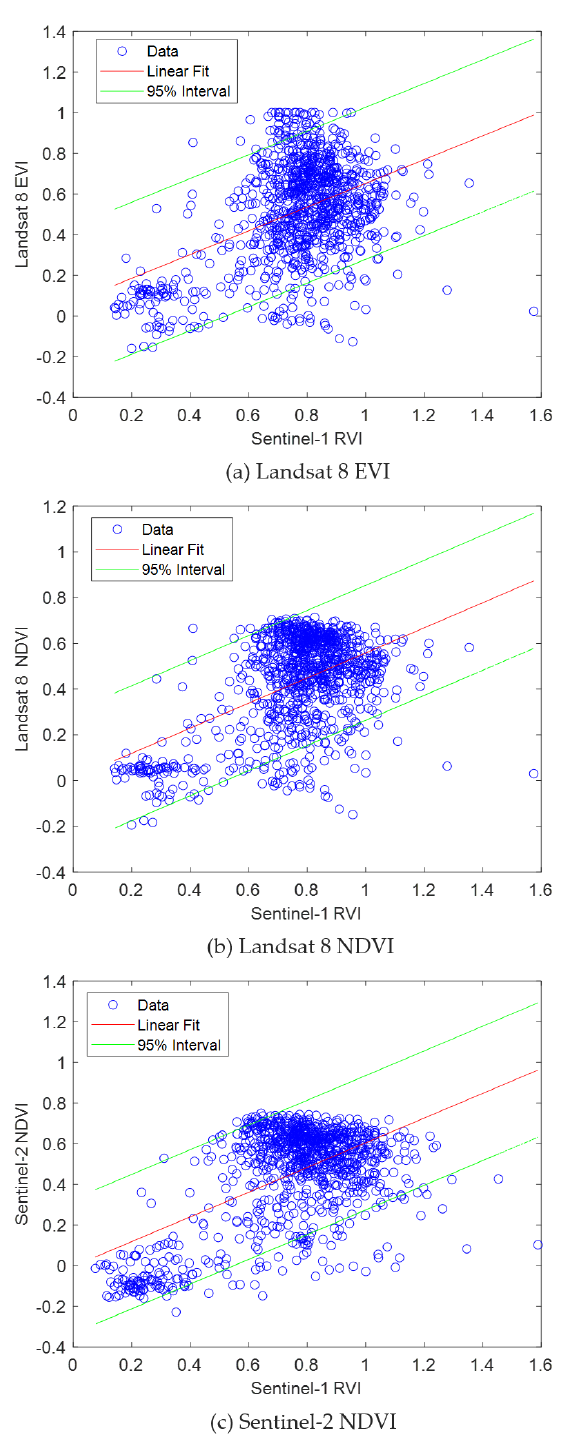
Figure 13. Linear regression lines with red color between radar vegetation index calculated from SAR and the vegetation index (reference) data in 2019. The spaces between the two green lines are the 95% prediction